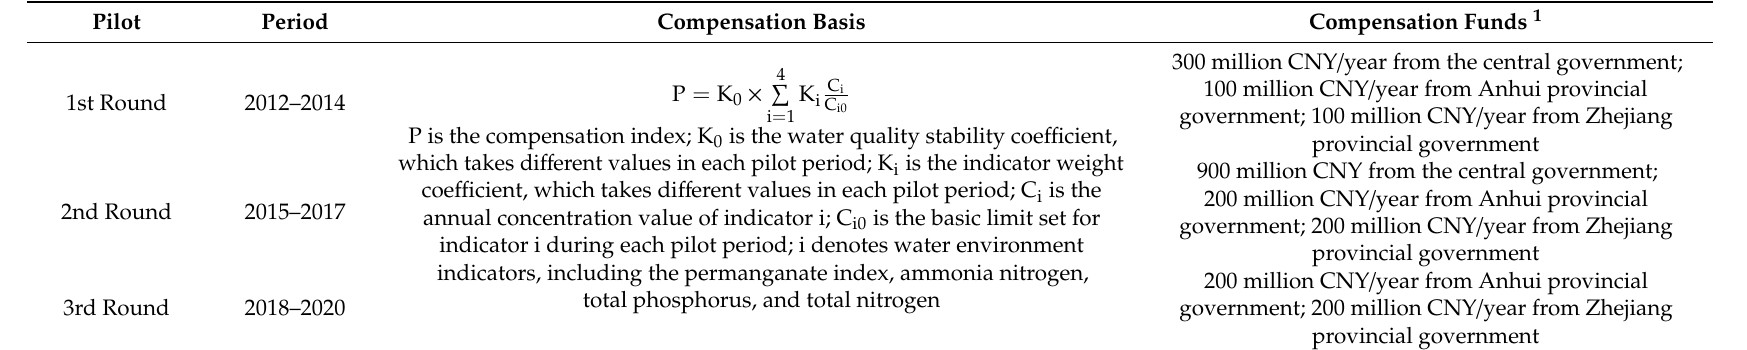
Table 1. Main contents of the three-round pilot agreement on the Xin’an River watershed ecological compensation